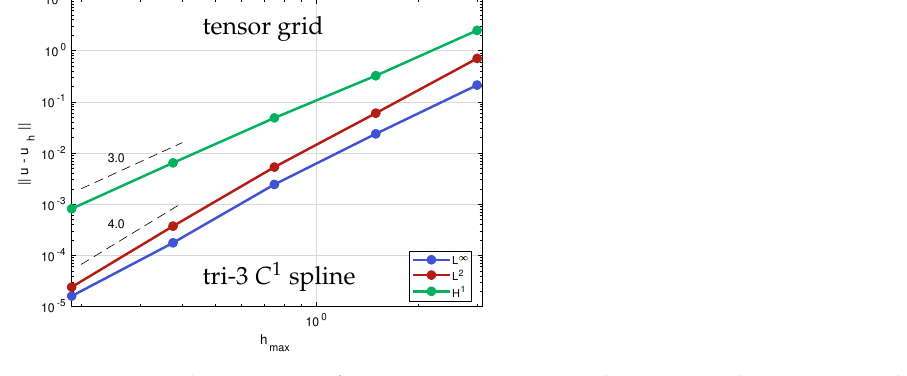
Figure 5. Optimal convergence for Poisson’s equation on the tensor grid. Error norms decreasing with h . The dashed lines labeled with n show slopes of 2 − n .